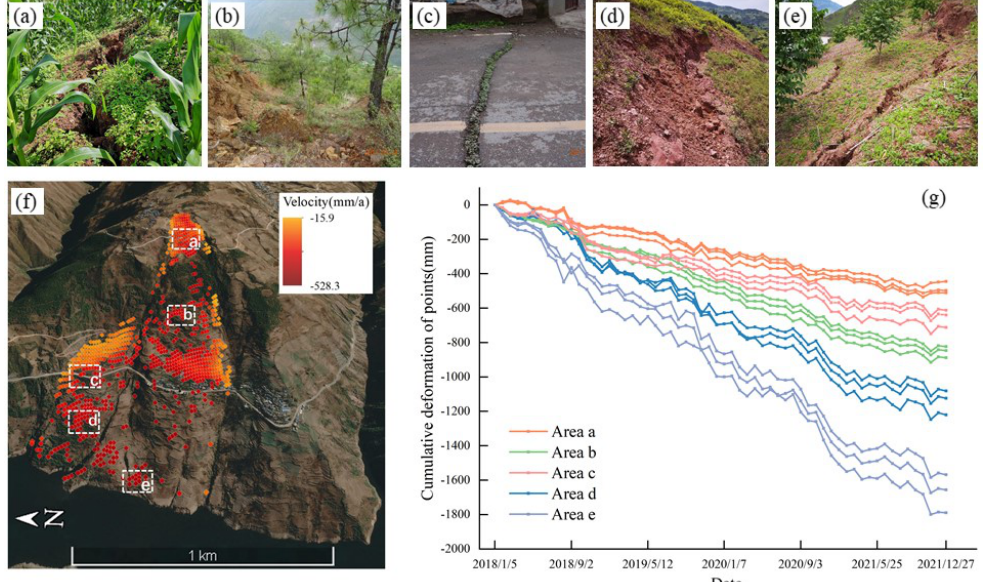
Figure 12. Field survey photos and monitoring results. ( a ) Cracks on the trailing edge (Area a in ( f )). ( b ) Faults in the middle − upper part (Area b in ( f )). ( c ) Fissures on the pavement in Cheyiping village (Area c in ( f )). ( d ) Cracks in the middle and lower part (Area d in ( f )). ( e ) Collapse on the front edge (Area e in ( f )). ( f ) Deformation rates of regional typical points. ( g )Accumulated settlement of three typical points in each area of ( f